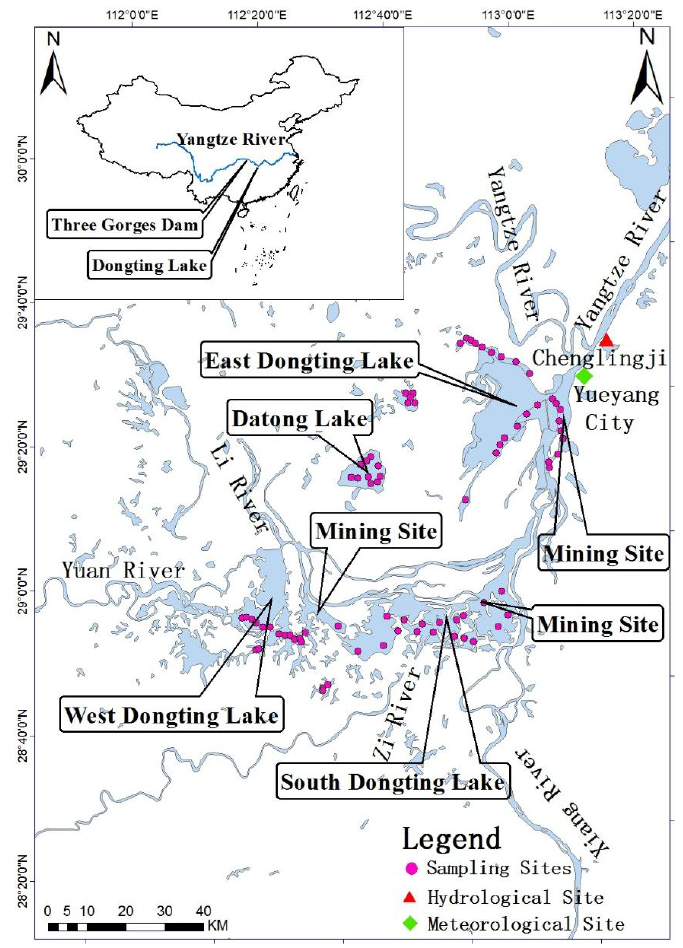
Figure 1. Location map of Dongting Lake in China. The pink points represent the sampling sites, and the red triangle and green rhombus represent the location of the Chenglingji hydrological site and the Yueyang meteorological site, respectively. The river’s direction of flow is the same as the alphabetical order of the name of each